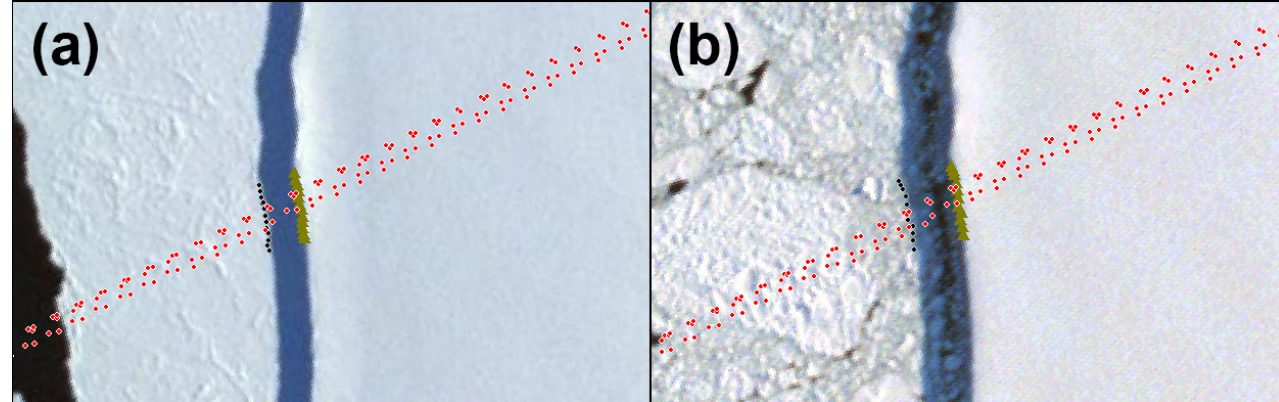
Figure 17. Detail of Abbot ice shelf Zone 2. Red dots show the center points of ICESat laser altimetry footprints used as reference freeboard height measurement. The points on the ice shelf margin chosen as shadow projectors are shown as brown triangles, and their respective shadows are shown as black dots: ( a ) ASTER scene from January 2005 (solar elevation of 5.1° and calculated refraction of 9.6 arcminutes); and ( b ) ASTER scene from January 2002 (solar elevation of 3.7° and calculated refraction of 12.5